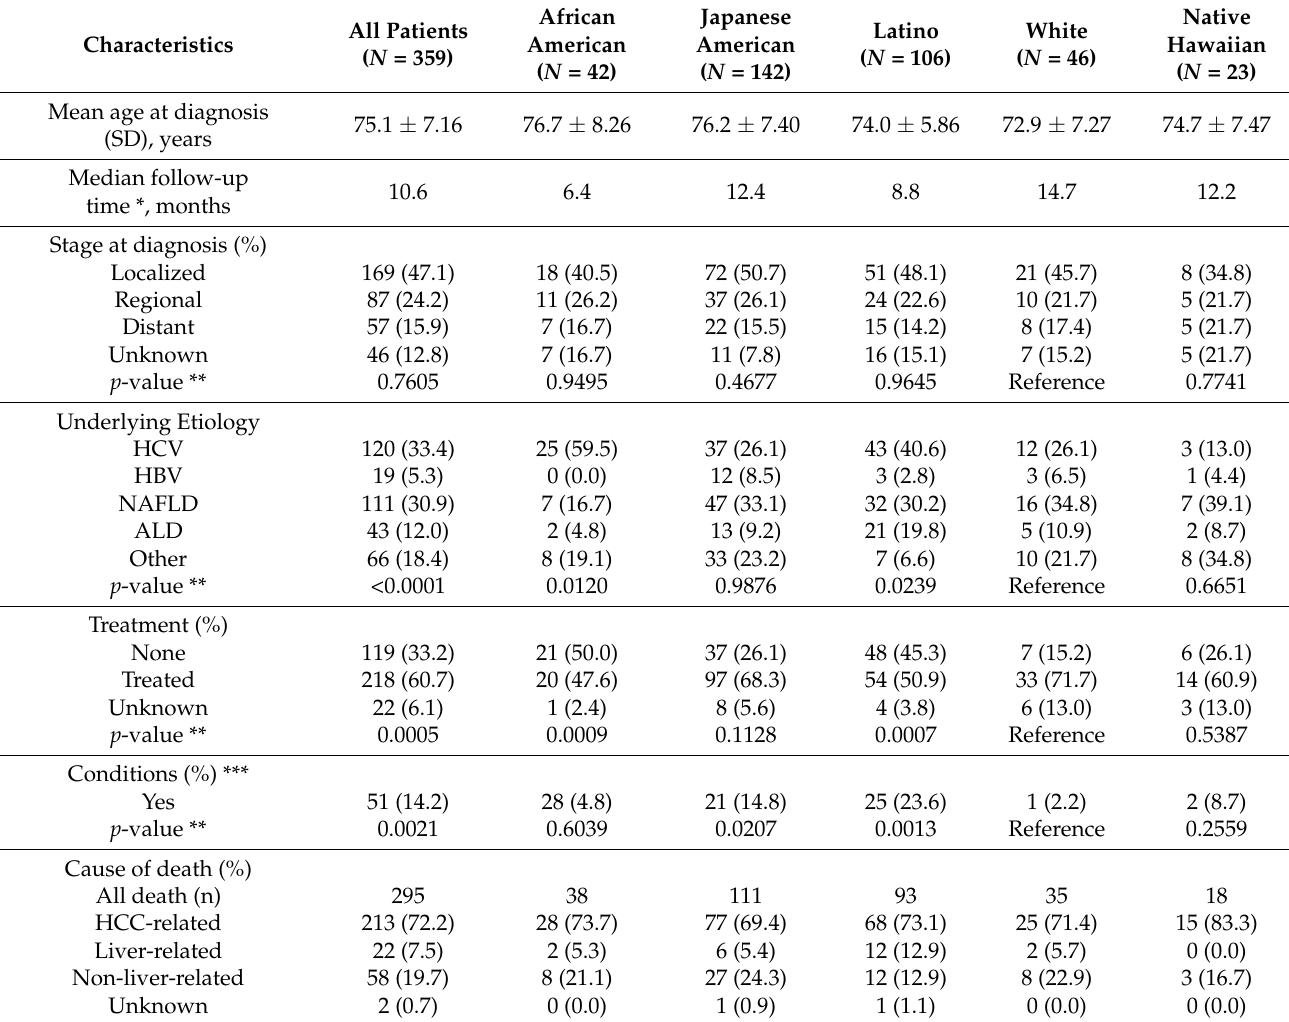
Table 2. Tumor characteristics of HCC and deaths in the Multiethnic Cohort by race/ethnicity.